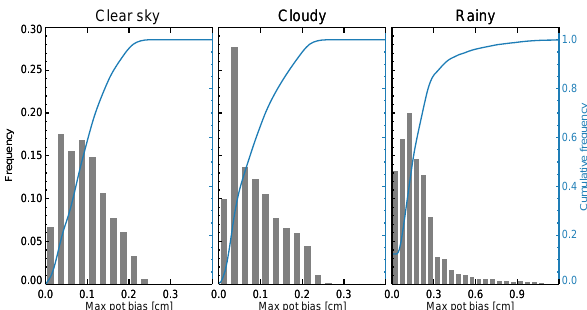
Figure 6. Histogram (gray) and cumulative histogram (blue) of the maximum potential biases for CloudSat-driven end-to-end total col- umn water vapor retrievals for each of the CloudSat measurements available from 15 January